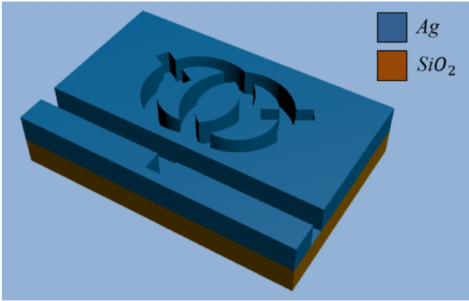
Figure 2. 3D structural